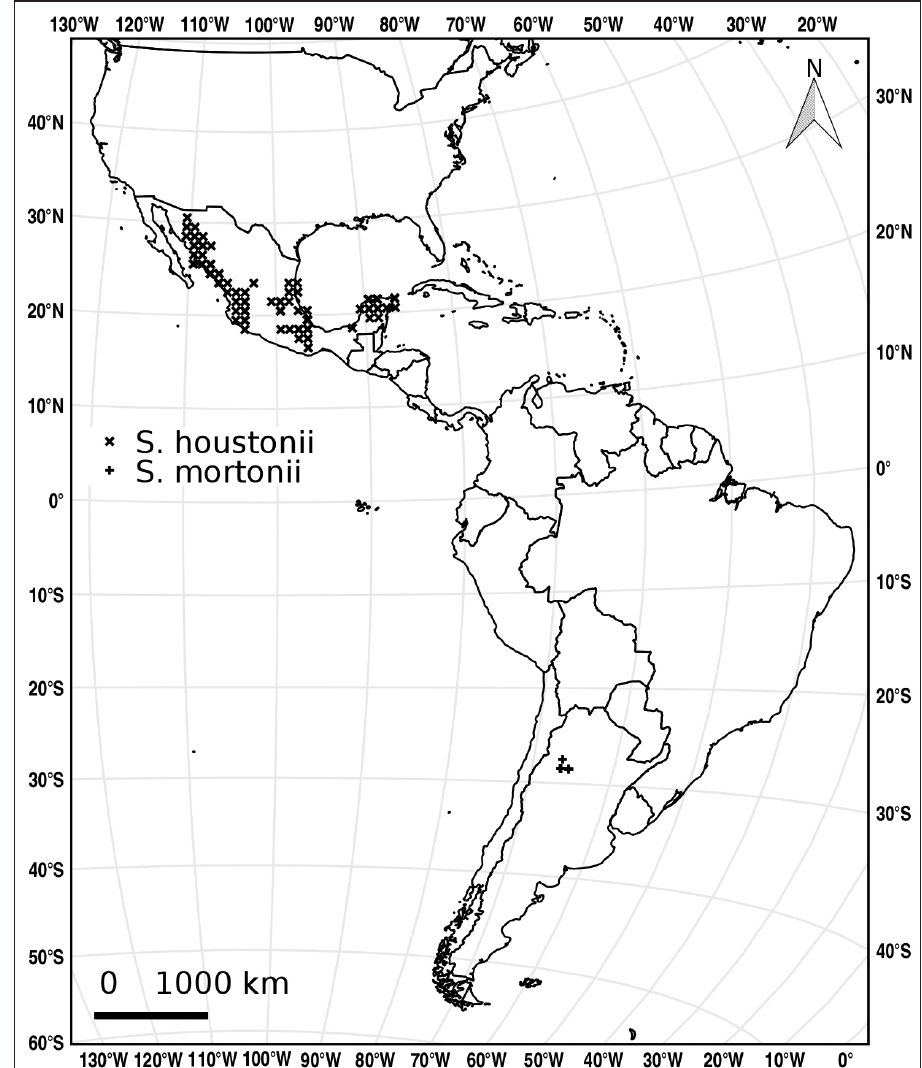
Figure 12. Distribution of S. houstonii and S. mortonii